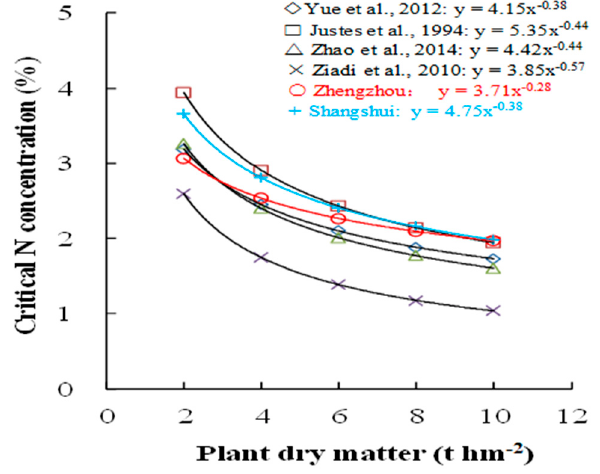
Figure 5. Comparisons of the critical N dilution curves of wheat plant obtained in Zhengzhou and Shangshui with previously published curves.